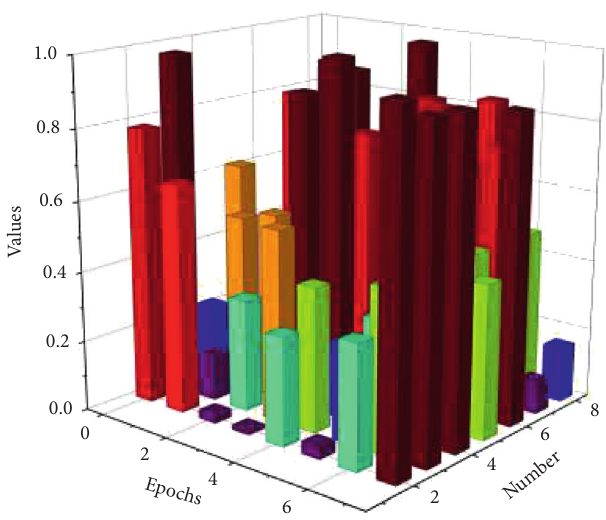
Figure 6: Prediction results of principal component